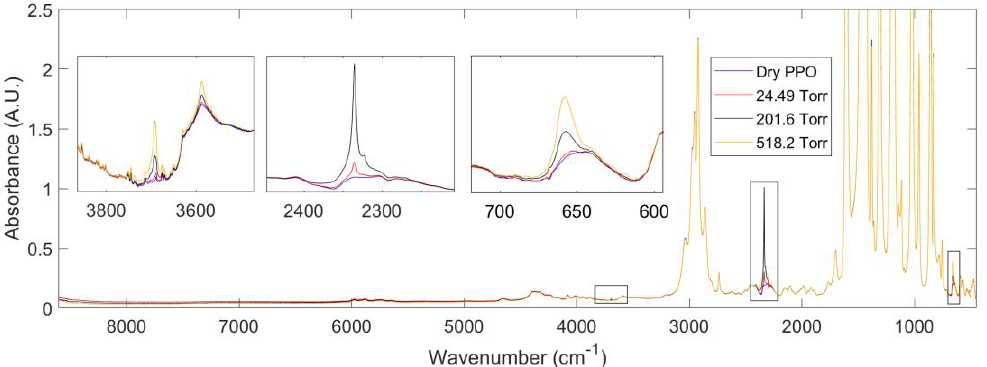
Figure 4. Absorbance spectra at 35 °C collected at sorption equilibrium after removal of the gas phase spectrum at 2 cm −1 resolution. The insets show the frequency regions in which carbon dioxide absorbs IR light within the polymer phase. In the range [2200,2450] cm −1 , the spectrum at 518.2 Torr is saturated and is not reported for the sake of clarity.